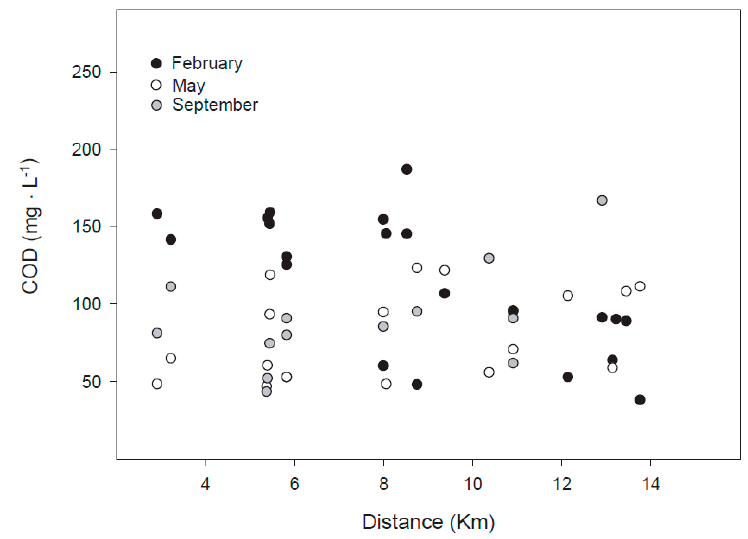
Figure 4. Effect of distance in the concentration of COD (chemical oxygen demand) in treated wastewater during three seasons: February ( p = 0.009); May ( p = 0.322); and September ( p = 0.848).